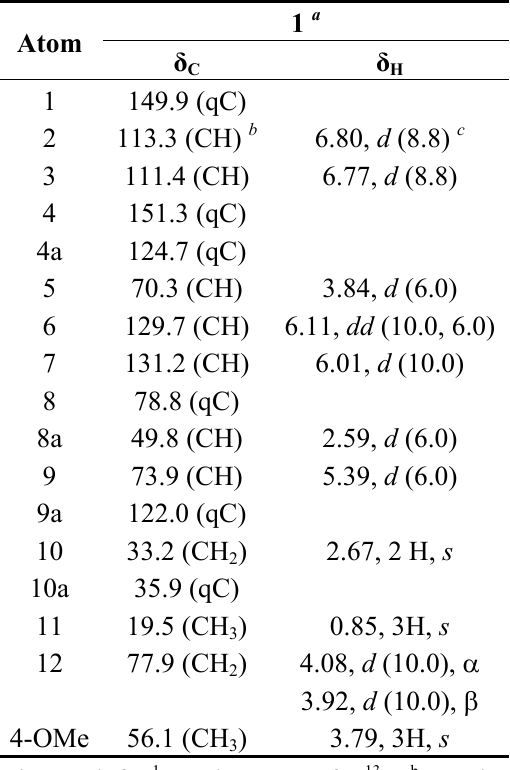
Table 1. 1 H and 13 C-NMR chemical shifts for 1